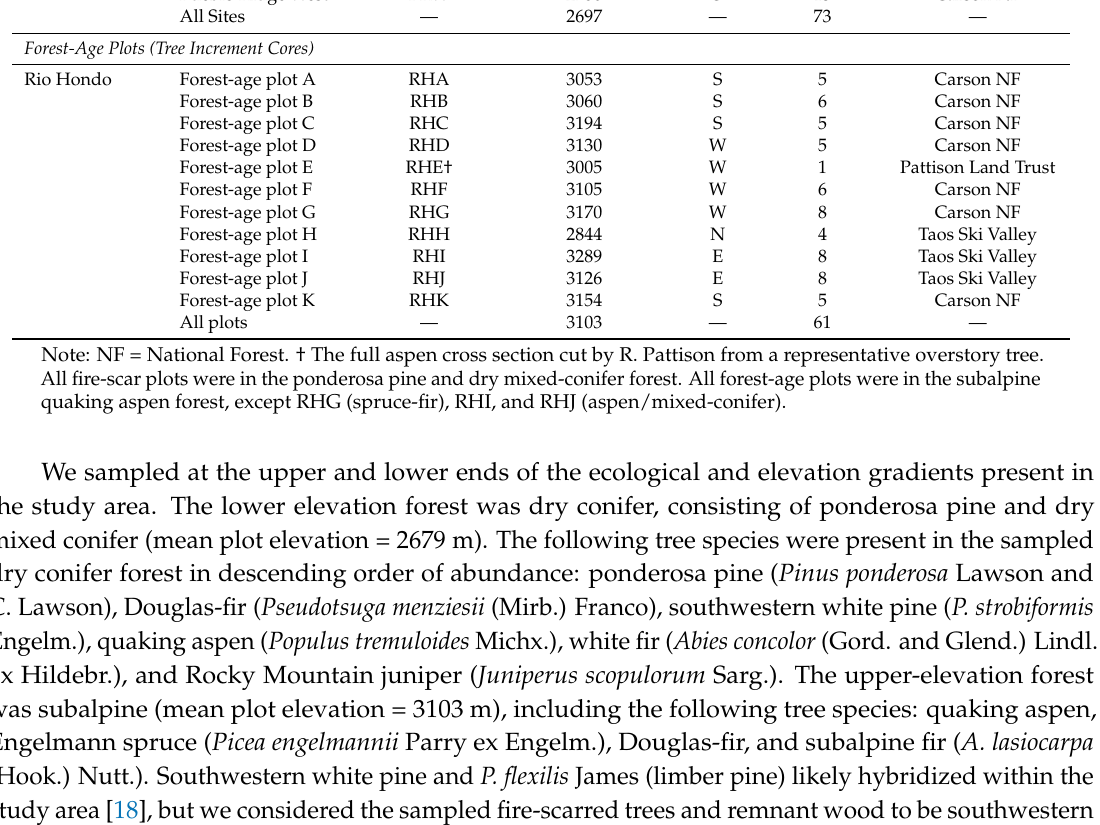
Table 1. The tree-ring fire-scar plot and forest-age plot information for the Taos Valley Watersheds. The fire-scar plots are ordered from north to south. Watershed Plot Name Plot Code Mean Site Elev. (m) Aspect Dated Trees Ownership Rio Hondo Manzanita Canyon